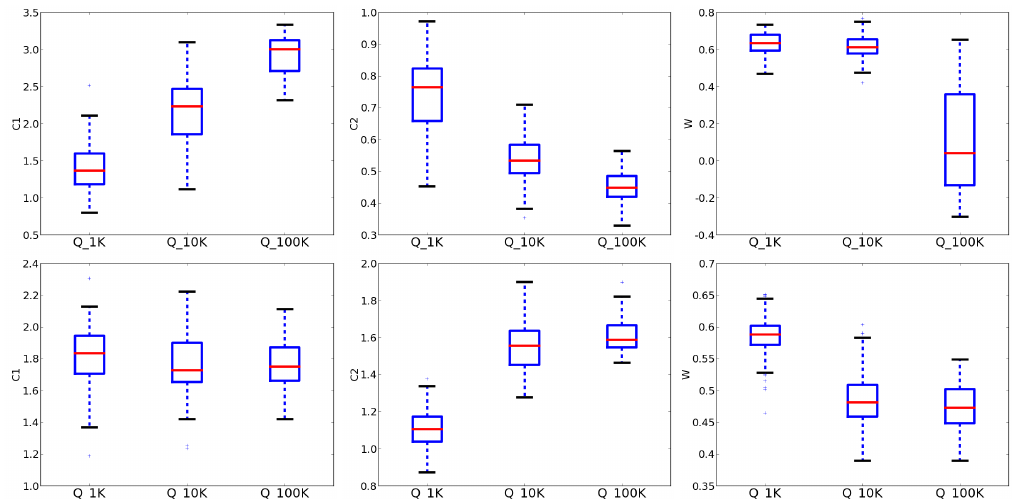
Figure 5. PSO parameters of the top solutions (best 10% of the population) for the 30-dimensional Rastrigin (first row) and Sphere (second row) functions, with an available budget of 1000, 10,000, and 100,000 fitness evaluations. Descending/ascending trends for all parameter values are clearly visible.